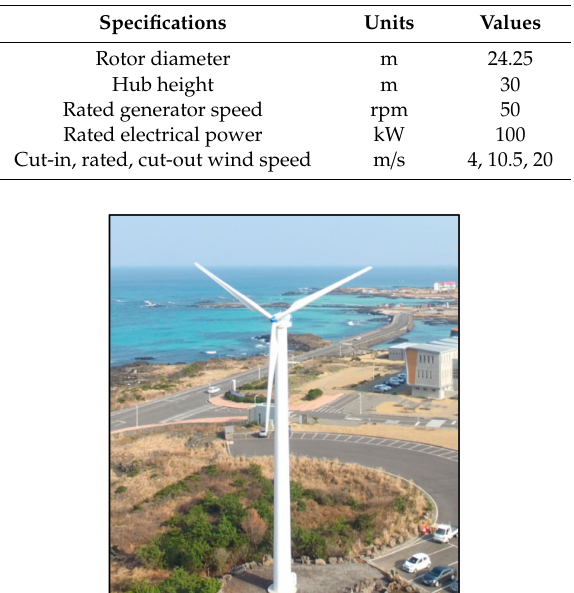
Table 1. Specifications of the target wind turbine.